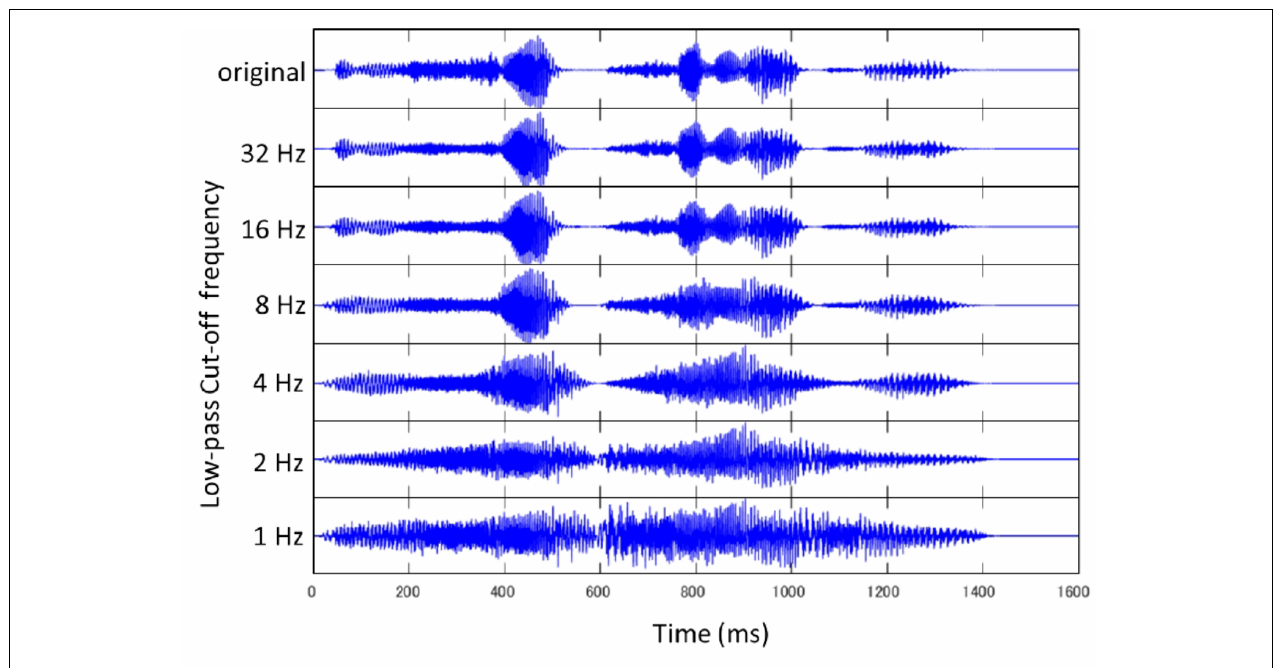
FIGURE 3 | The waveform of “It is so pretty up here” (original) is shown at the top. The waveform of modulation-filtered speech is displayed below next to the corresponding low-pass cut-off frequency: 32, 16, 8, 4, 2, and 1